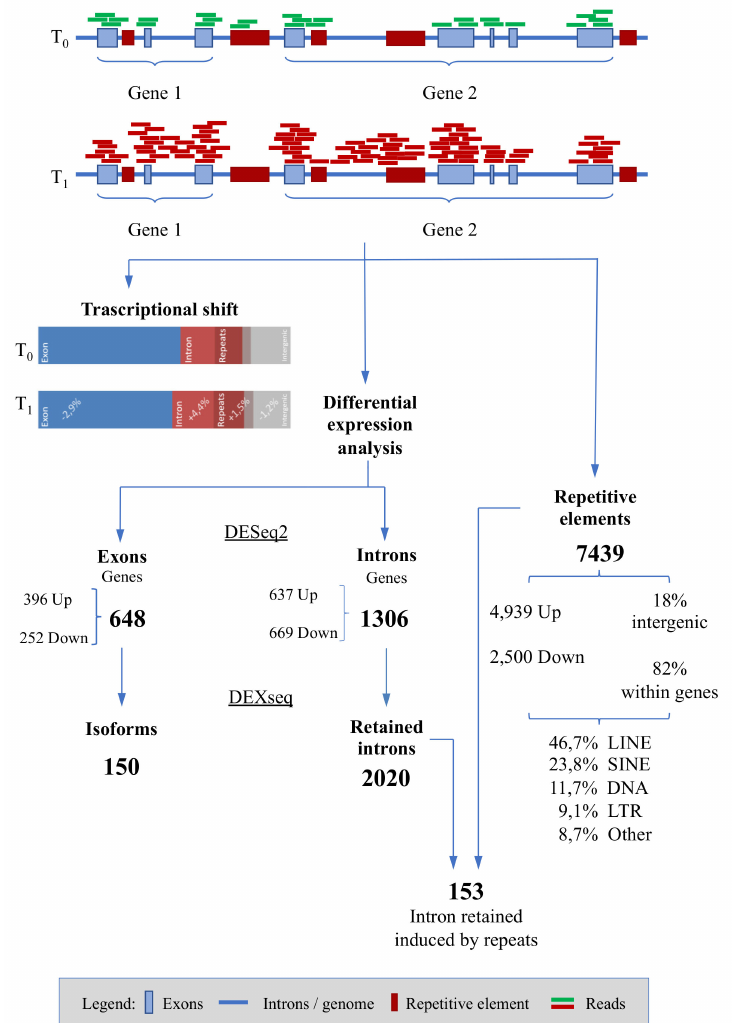
Figure 1. Cartoon depicting results in the context of the method